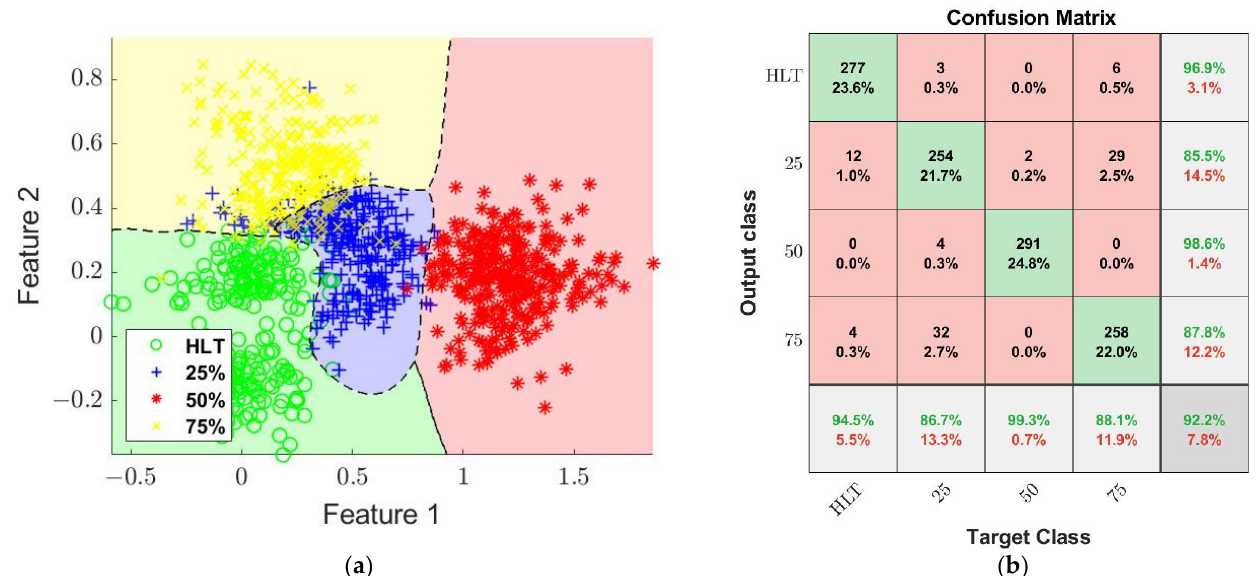
Figure 10. Features optimization through GA and data fusion (current signal and Ay and Az vibration signals), in ( a ) Two-dimensional projection of clusters (fault conditions) through LDA with limit bounds, and ( b ) Confusion matrix that validates the ANN classification of faults.